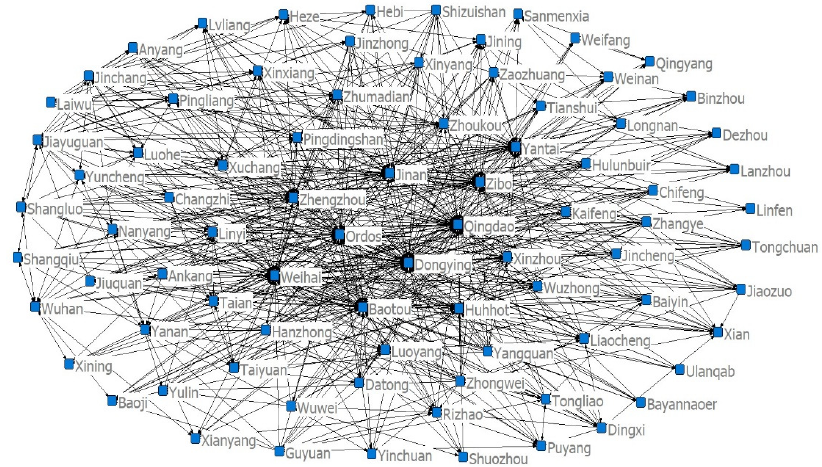
Figure 6. Spatial correlation network diagram of the UECC in the YRB.